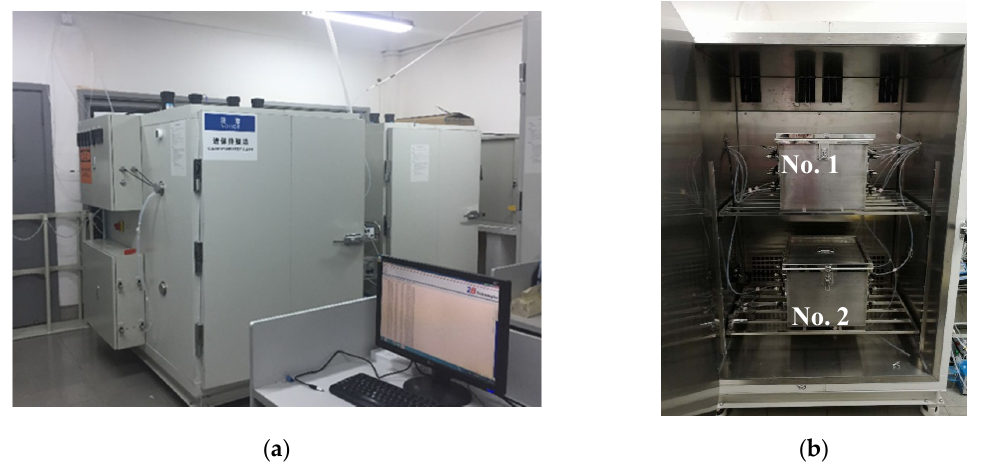
Figure 1. The laboratory chamber apparatus. ( a ) Environmental chamber. ( b ) Two emission chambers with multiple ports.